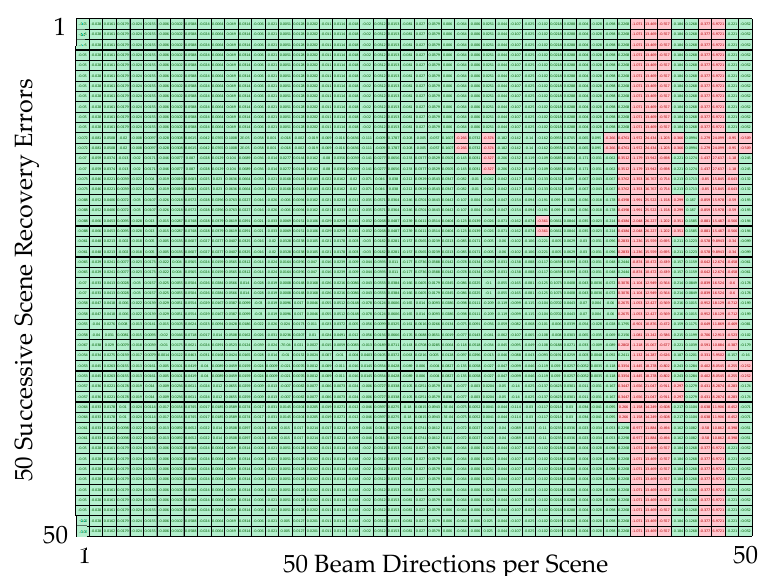
Figure 13. Map of the percentage differences between the two images shown in Figure 12. Green cells indicate errors less than ±0.25 percent, pink cells indicate errors greater than ±0.25 percent.